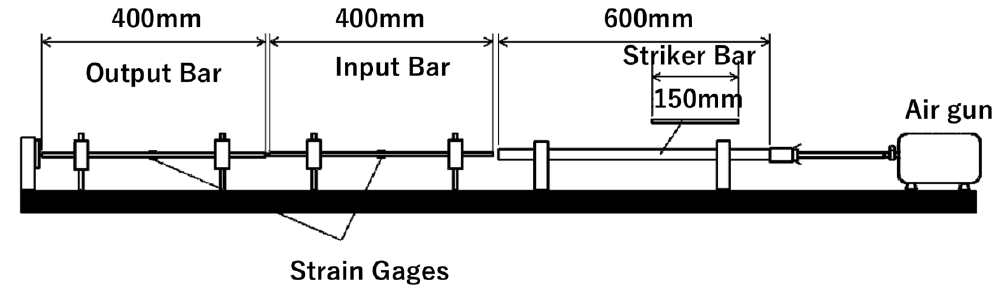
Figure 3. A schematic illustration of established miniature split Hopkinson pressure bar (SHPB) testing apparatus.